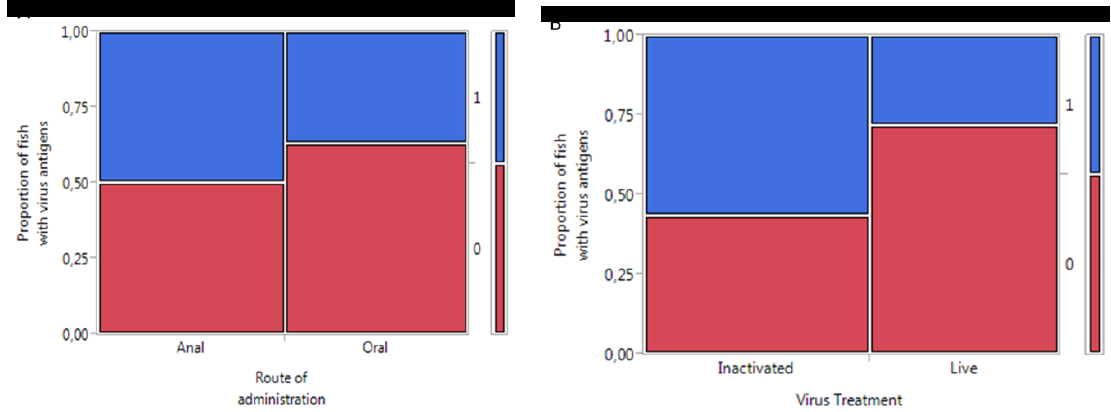
( B ) comparison between virus treatments. Key: 0 = no antigens detected; 1 =